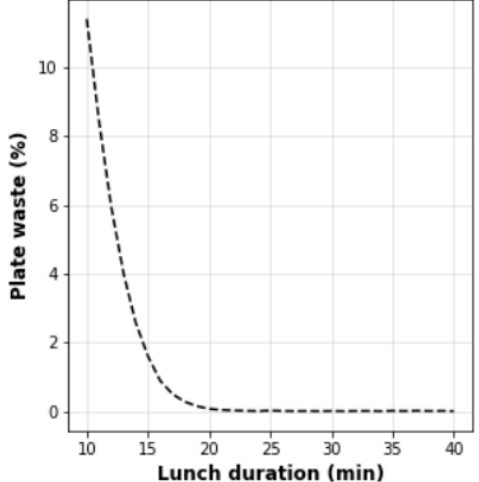
Figure 11. Lunch duration in the ideal conditions.